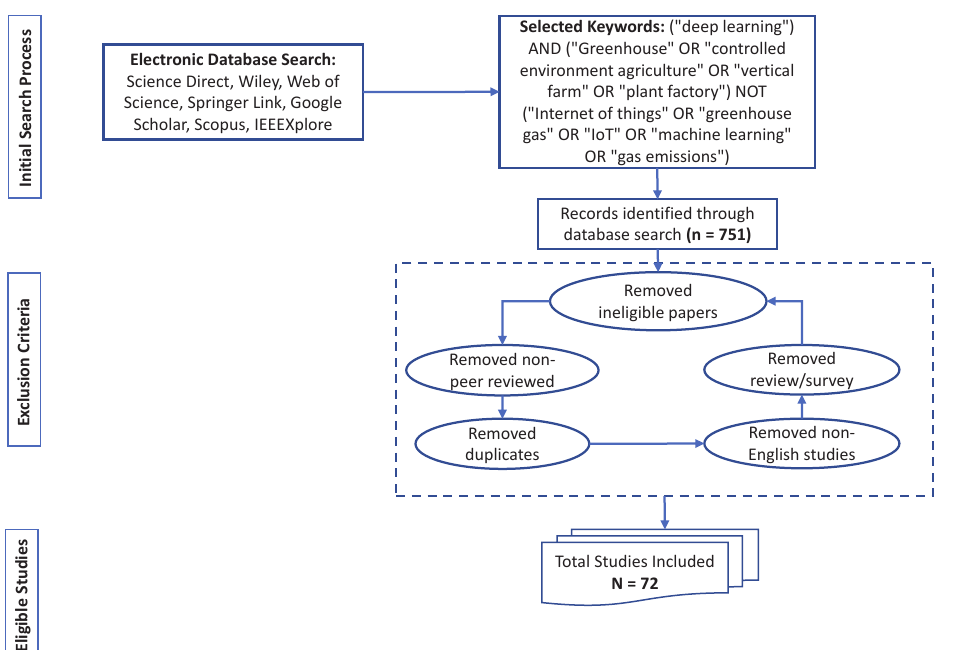
Figure 3. Article inclusion and exclusion process